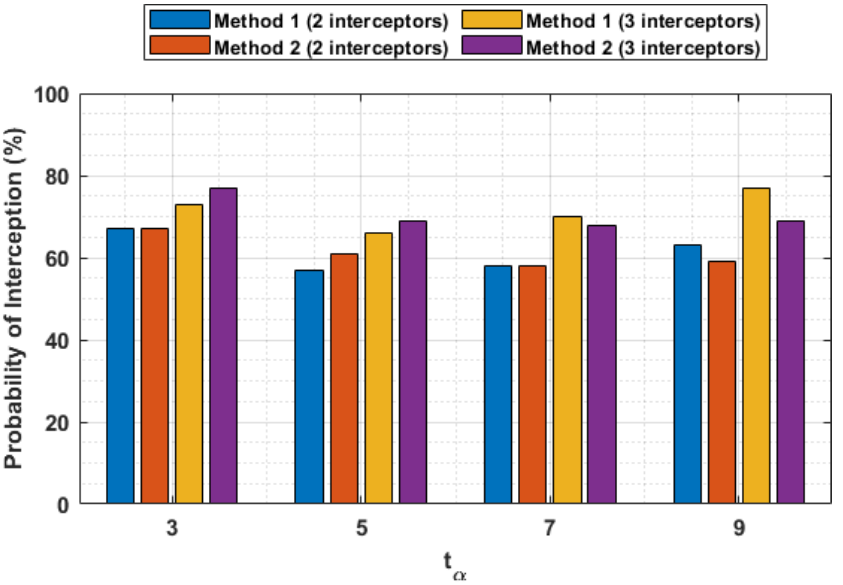
Figure 12. Comparison of probability of interception for all t α , in Case